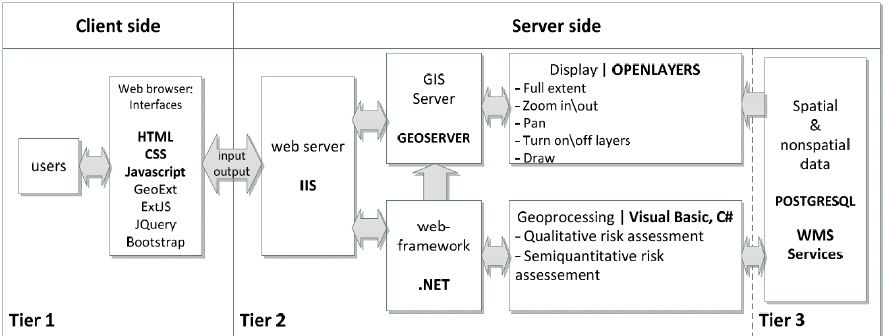
Figure 4. RiskOTe technical architecture.